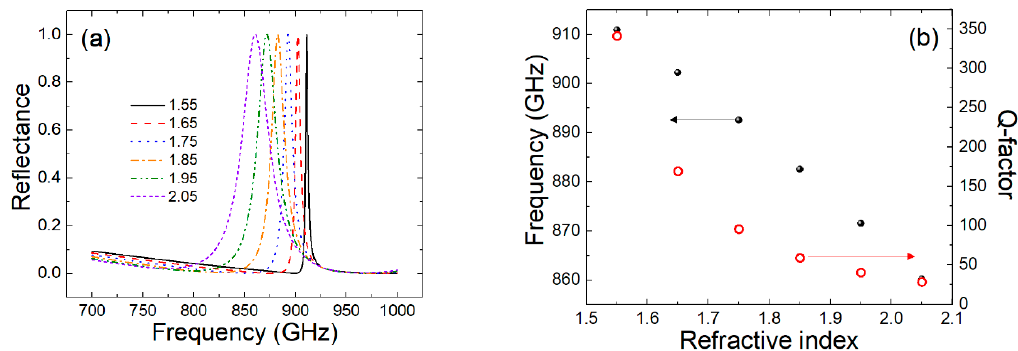
Figure 4. ( a ) Scheme of the simulated THz reflectance with varying refractive index of the grating layer; ( b ) peak frequency and Q-factor for the circular pattern, where F = 0.25.